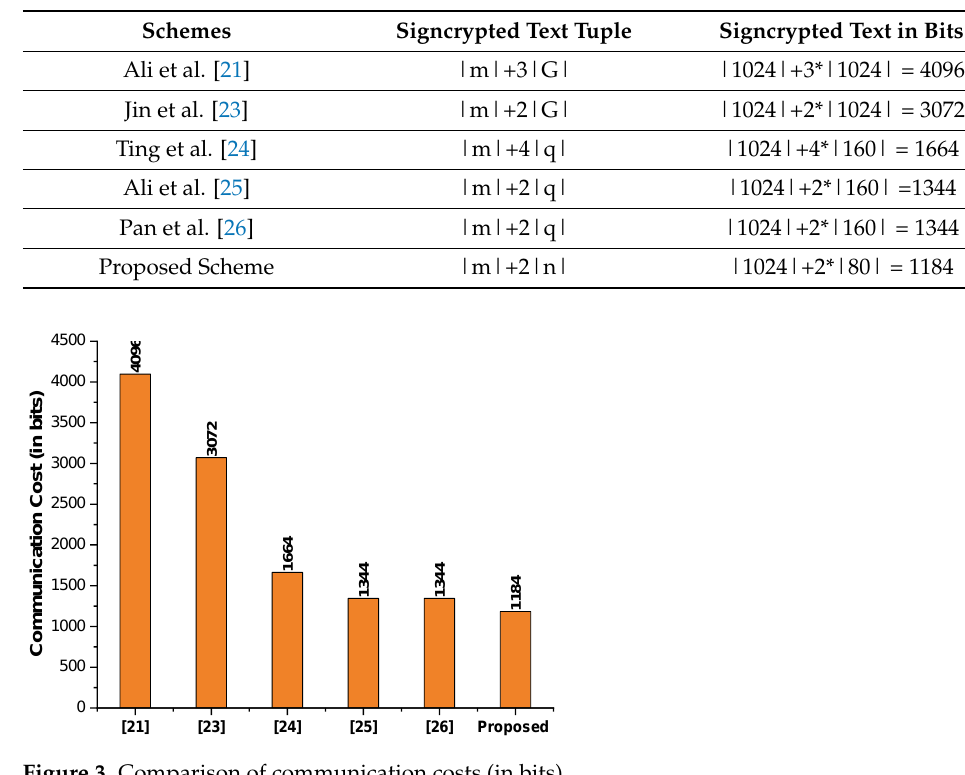
Table 5. Comparison of communication costs (in bits).